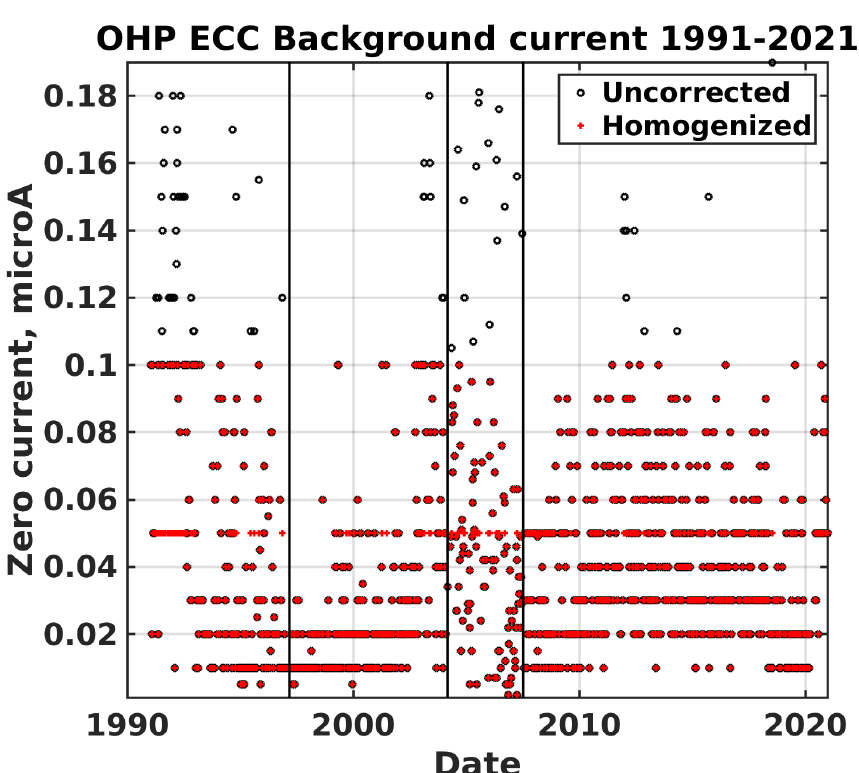
Figure 1. Time evolution of the OHP ECC background current from 1991 to 2021. The red crosses are the currents after homogenization and the black circle before. The black lines correspond to the major ozonesonde changes in 1997, 2004 and 2007 (see Fig.